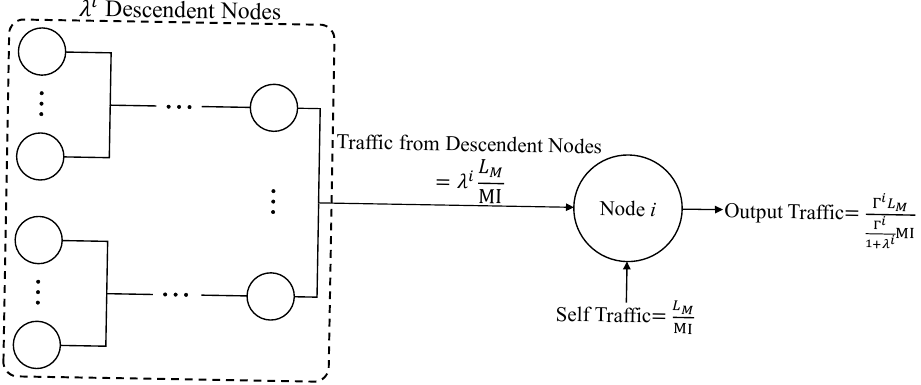
Figure 1. Conservation of traffic flows at a non-leaf